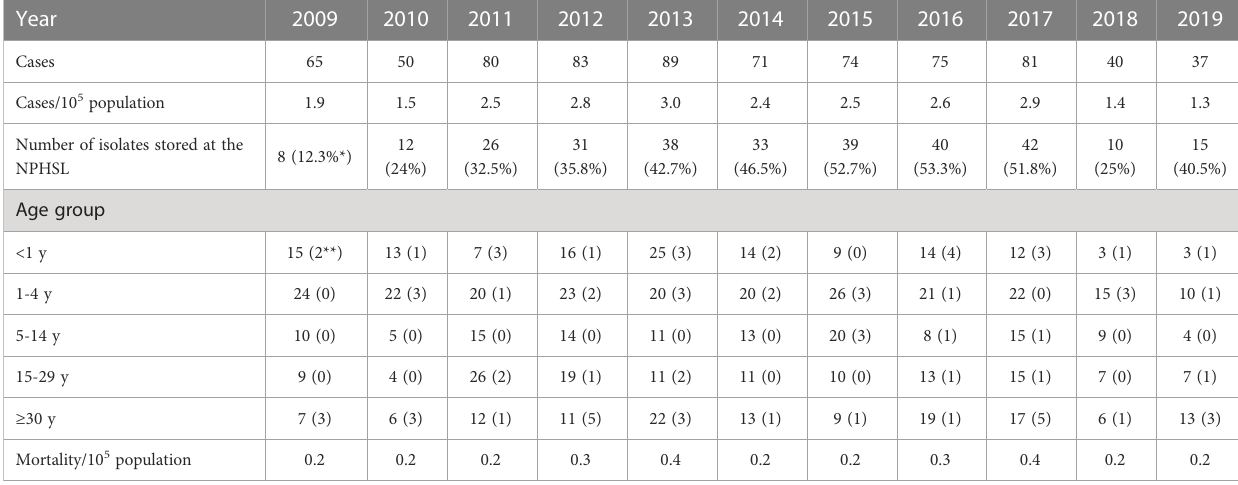
TABLE 1 Distribution of IMD cases by year and